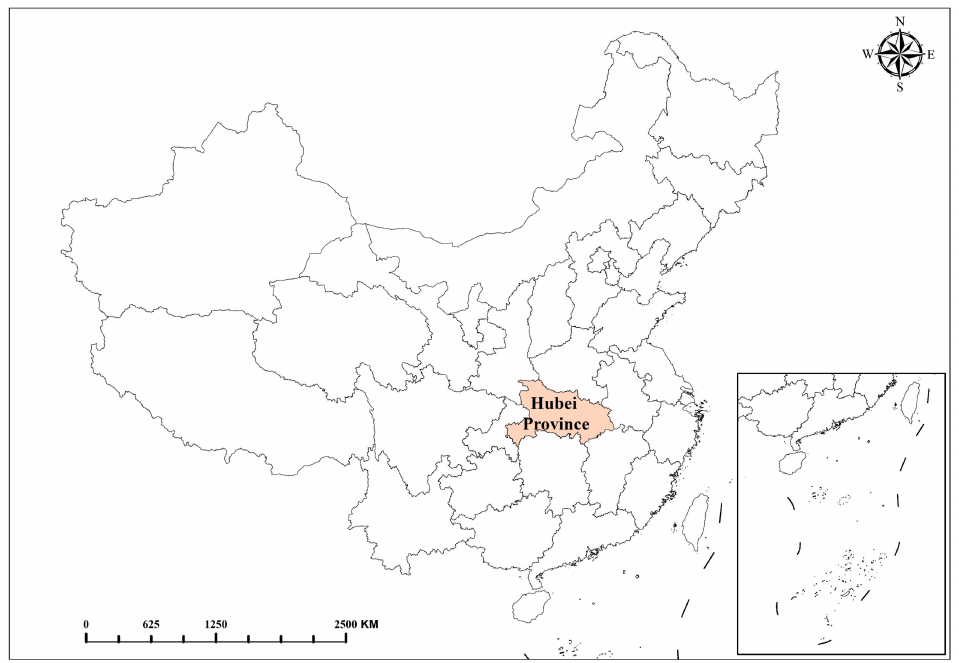
Figure 1. Location of Hubei